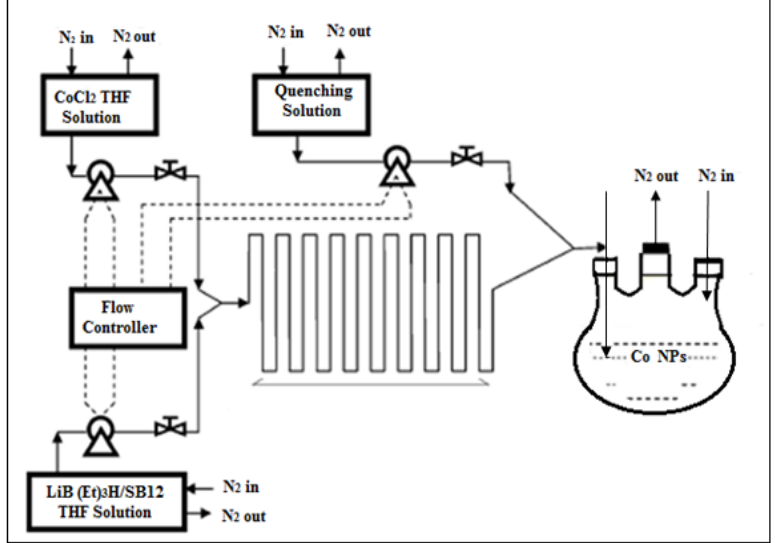
Figure 17. Schematic of the phase-controlled synthesis of cobalt nanoparticles